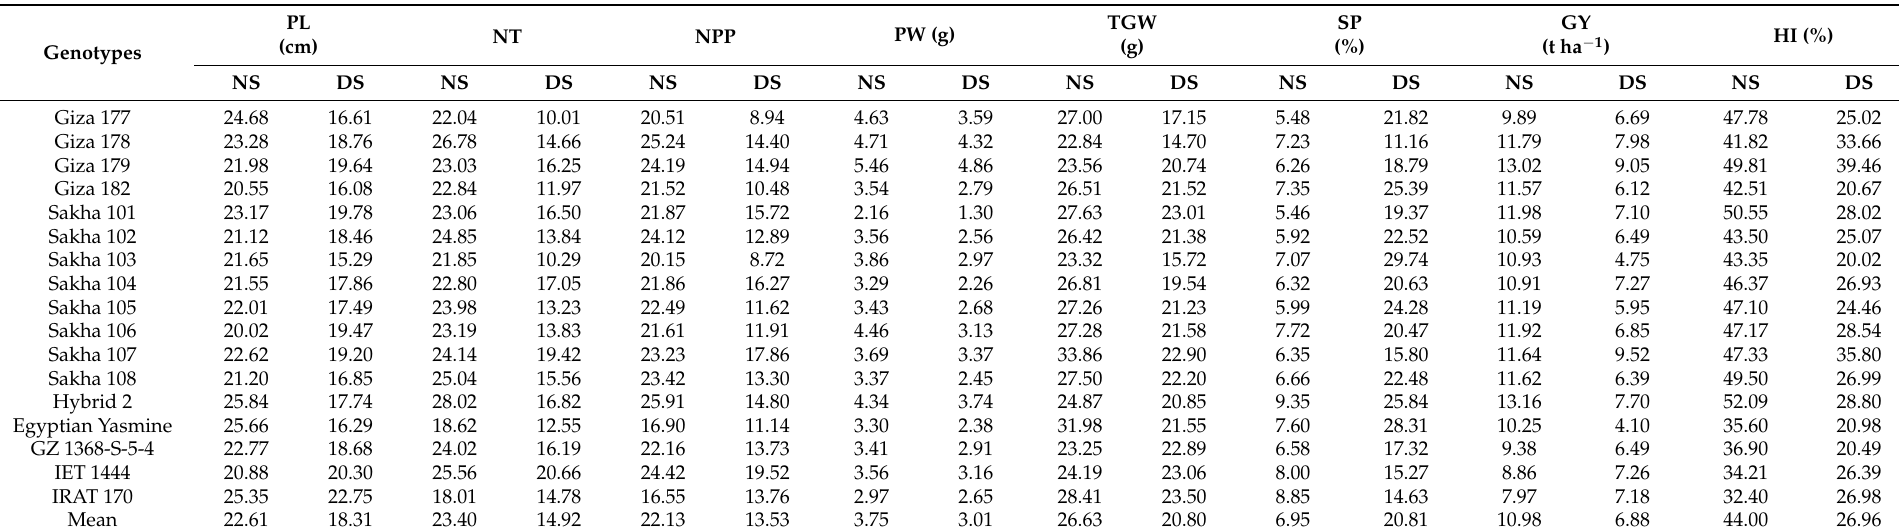
Table 7. Agronomic and yield traits of rice genotypes under water-deficit (DS)